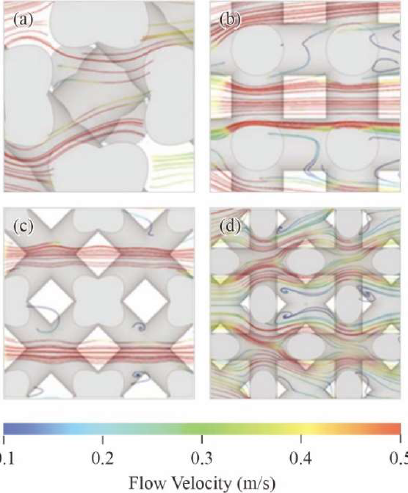
Figure 6. Streamline distributions of high-temperature liquids in the dendritic lattices visualized by computer fluid dynamics (CFD). The flux densities and color variations indicate the fluid amounts and velocities, respectively. The fluid profiles ( a – d ) were simulated in the 4-, 6-, 8- and 12-coordinated lattices, respectively.